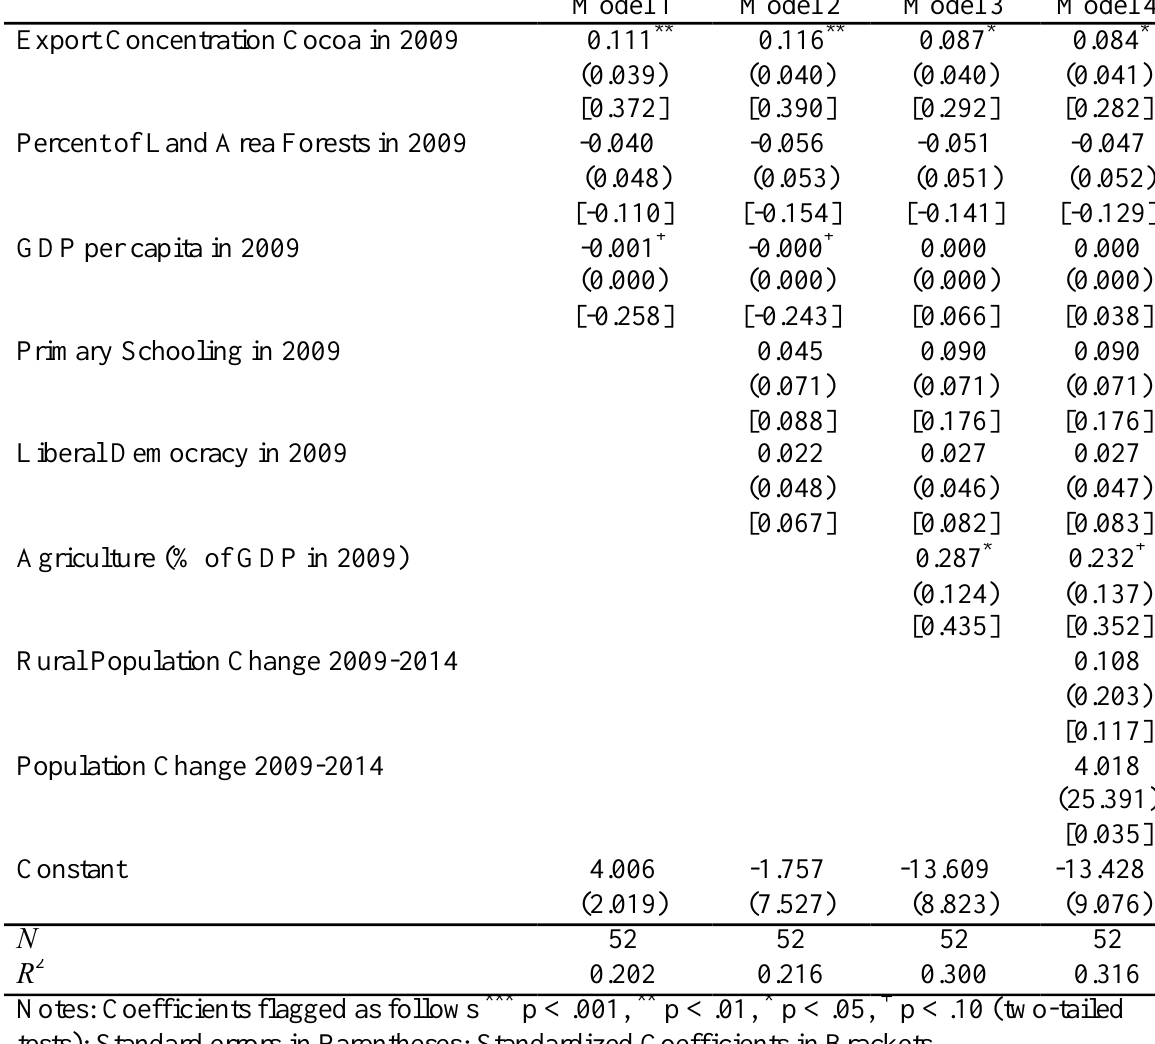
Table 8. OLS Regression Predicting Deforestation